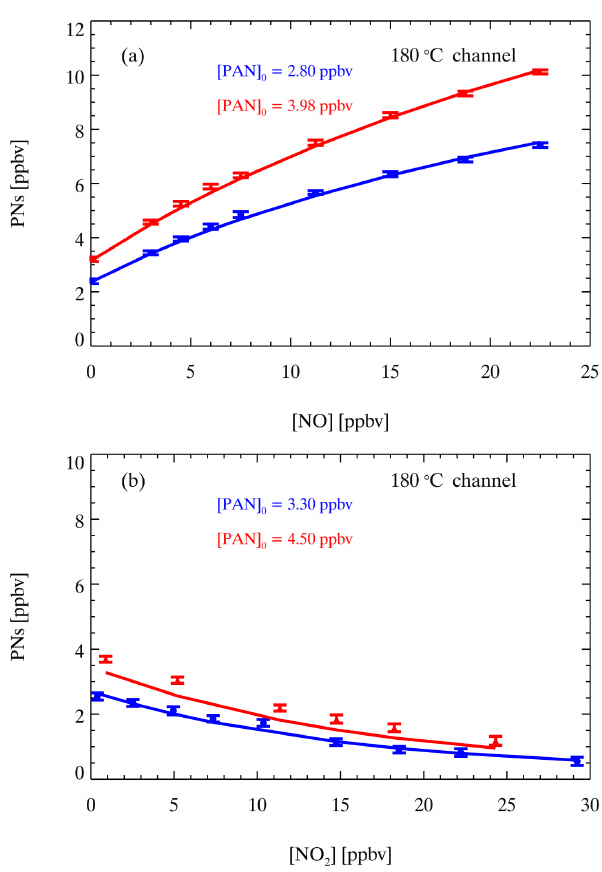
Figure 9. Simulated (lines) and measured (points) differences be- tween the NO 2 signal in the PN channel and reference channel for different PAN samples with different added amounts of NO (a) and NO 2 (b) . The error bars show 1 standard